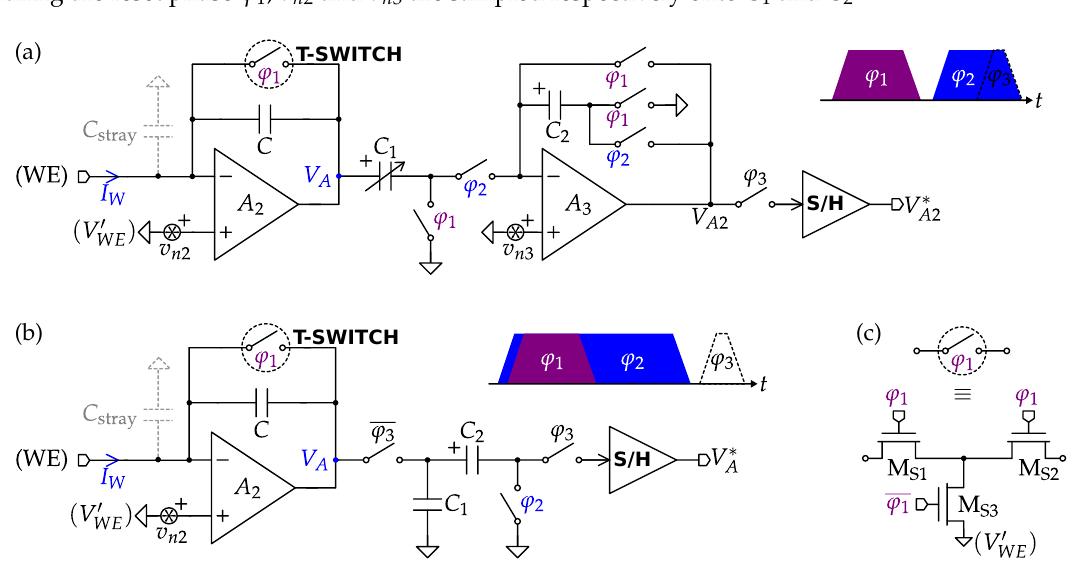
Figure 13. Switched-capacitors amperometric readout schemes including flicker noise cancellation by correlated-double sampling. ( a ) conventional scheme; ( b ) without the programmable-gain amplifier; ( c ) T-switch